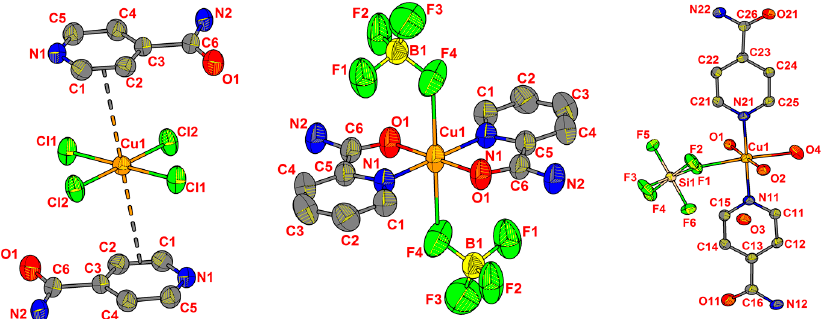
Figure 4. ORTEP representation (50% probability level) of the molecular entities within the structures of (HIna) 2 [CuCl 4 ] 2H 2 O ( 6 ) ( left ) of [Cu(Pia) 2 (BF 4 ) 2 ] ( 8 ) ( middle ) and [Cu(Ina) 2 (H 2 O) 3 (SiF 6 )] · H 2 O ( 4 ) ( right ); H atoms were omitted for clarity.